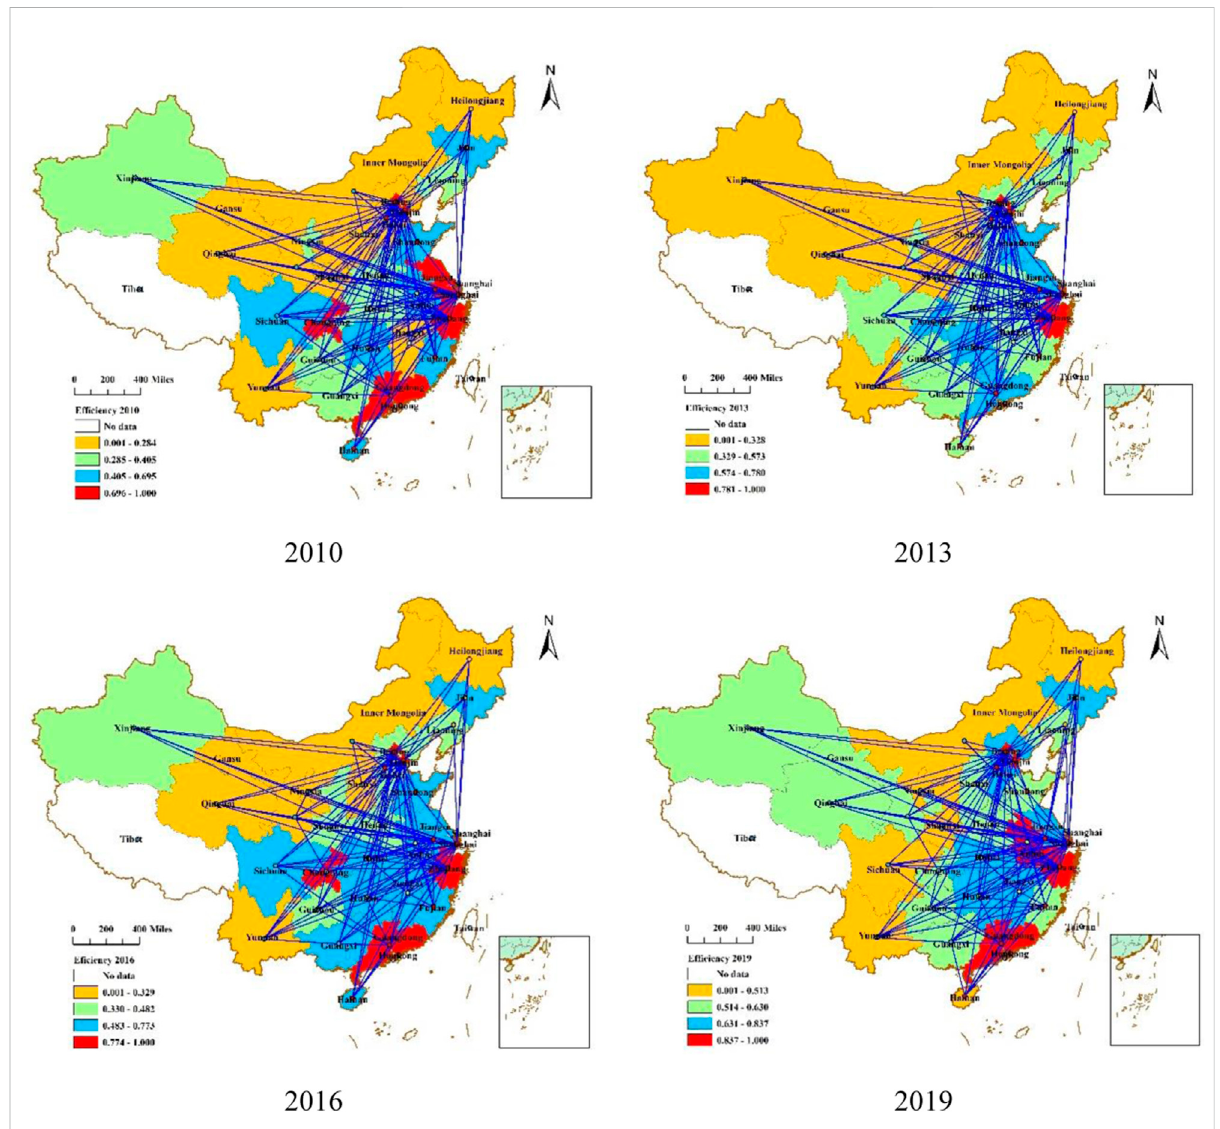
FIGURE 3 Spatial association network map of regional GIEs in